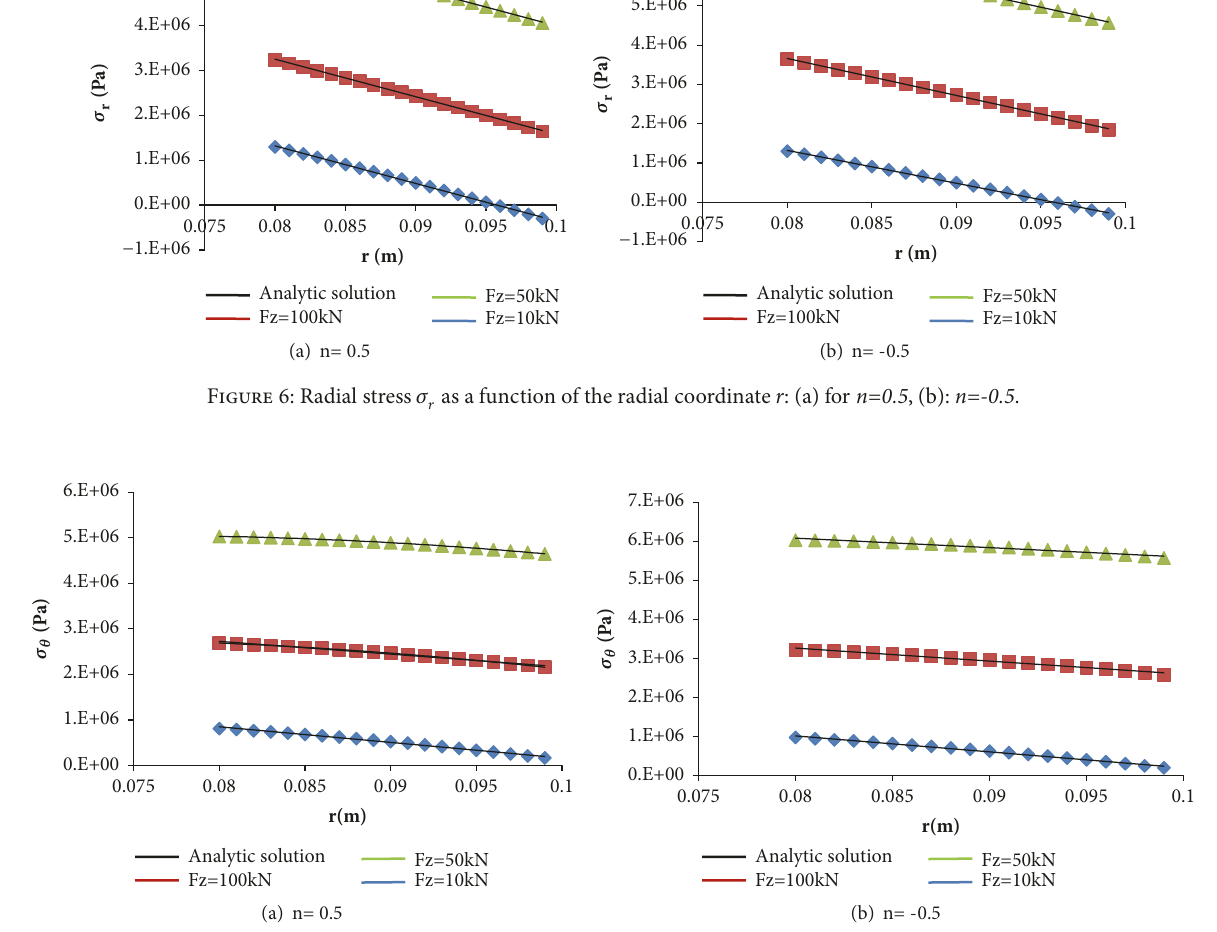
Figure 7: Tangential stress 𝜎 𝜃 as a function of radial coordinate r : (a) for n=0.5 , (b): n=-0.5